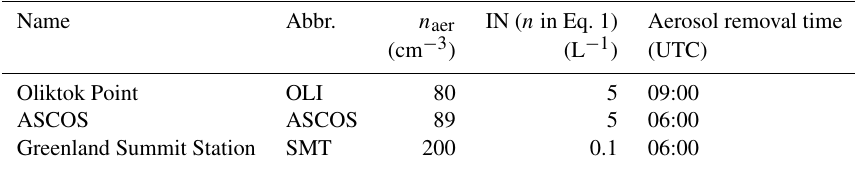
Table 1. Case names and abbreviations (Abbr.) along with the initial aerosol concentration ( n aer ), ice nuclei concentration (IN), and aerosol removal